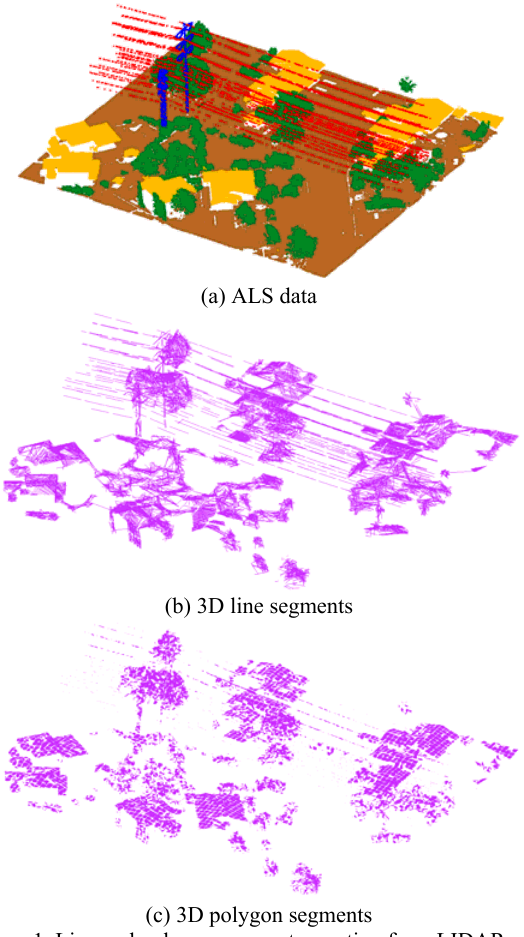
Figure 1. Line and polygon segments creation from